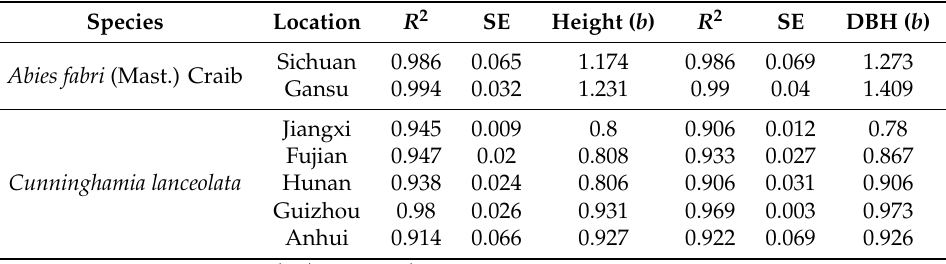
Table 2. Two-species growth di ff erence equation to estimate di ff erences between regions. Species Location R 2 SE Height ( b ) R 2 SE DBH ( b ) Sichuan 0.986 0.065 1.174 Abies fabri (Mast.) Craib